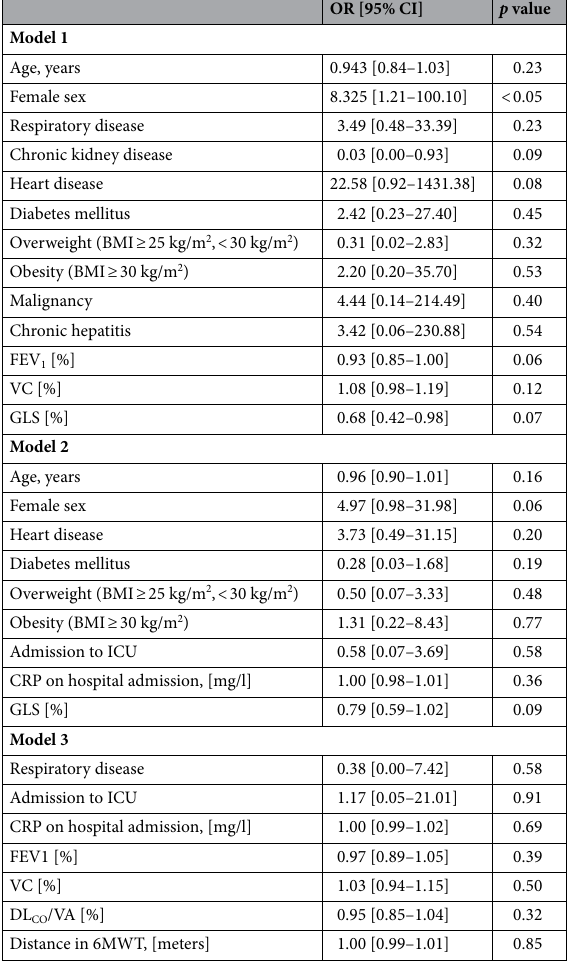
Table 4. Multivariate logistic regression at 6-month follow-up. Results from three multivariate logistic regressions, response variable is patient-reported fatigue at 6 months follow-up in each model. Regarding model 3: Pulmonary function tests in these models represent percentage of normal values (adjusted for age, gender, height and race). For numerical variables a one unit of change is associated with a change in likelihood of reporting fatigue at 6 months follow-up by the value reported in the OR column. OR > 1 increase the likelihood, while OR < 1 reduce the likelihood. OR, Odds-Ratio; 95% CI, 95% confidence interval; BMI, Body mass index in kg/m 2 ; FEV 1 , forced expiratory volume in 1s; VC, vital capacity; GLS, global longitudinal strain; CRP, C-reactive protein; DLco, diffusing capacity for carbon monoxide; VA, alveolar